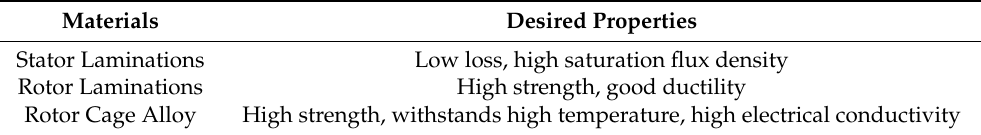
Table 2. Induction machine constituent materials and desired properties for high-speed IM.